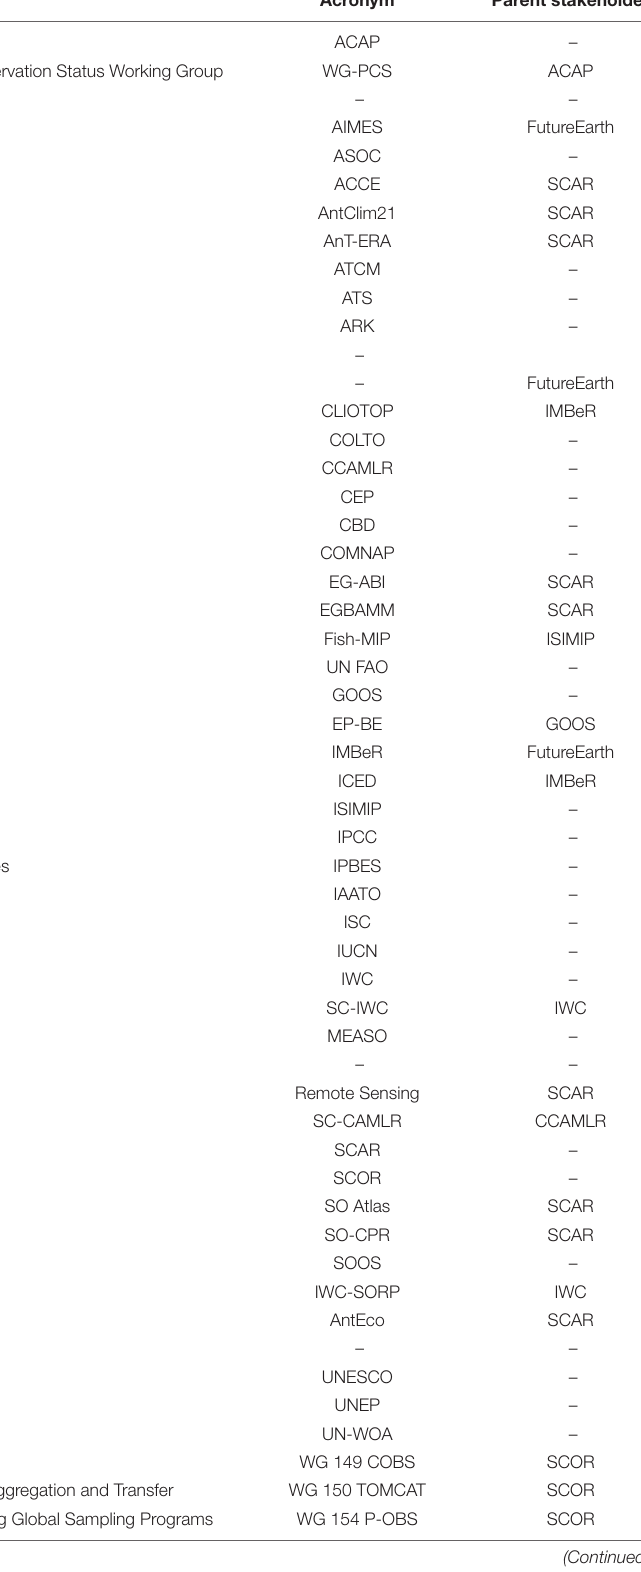
TABLE 3 | Full list of identified stakeholders in Southern Ocean ecosystem management, including their parent stakeholder (if applicable), and definitions of acronyms for stakeholder groups as used in Figures 1 , 2 , 4 and Supplementary Table 2 . Stakeholder Agreement on the Conservation of Albatrosses and